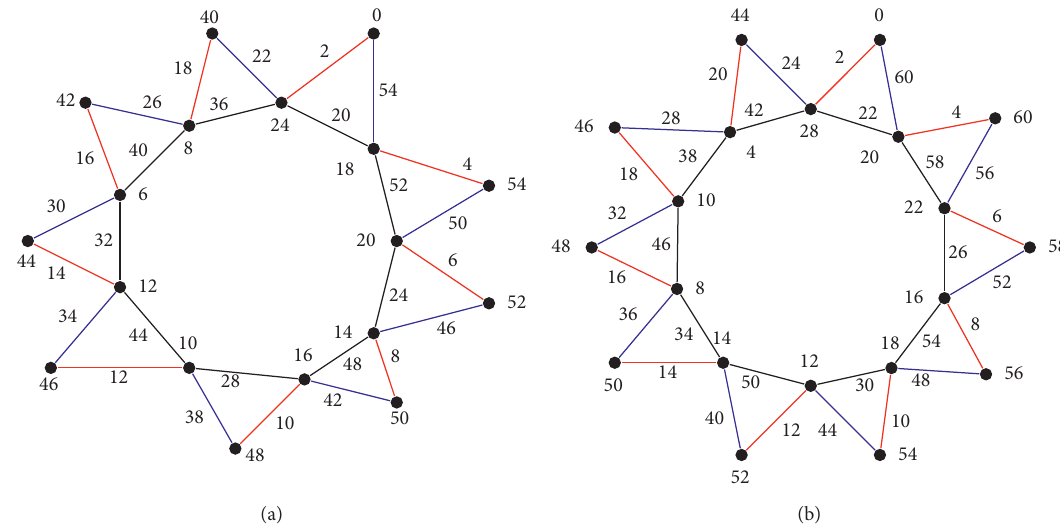
Figure 25: (a) A 2-edge even graceful labeling of sf